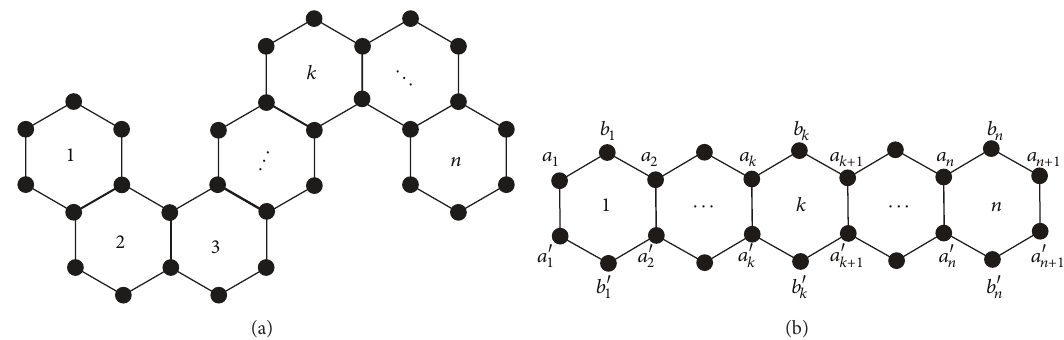
Figure 1: A benzenoid chain with 𝑛 hexagons (a) and the linear polyacene 𝐿 𝑛